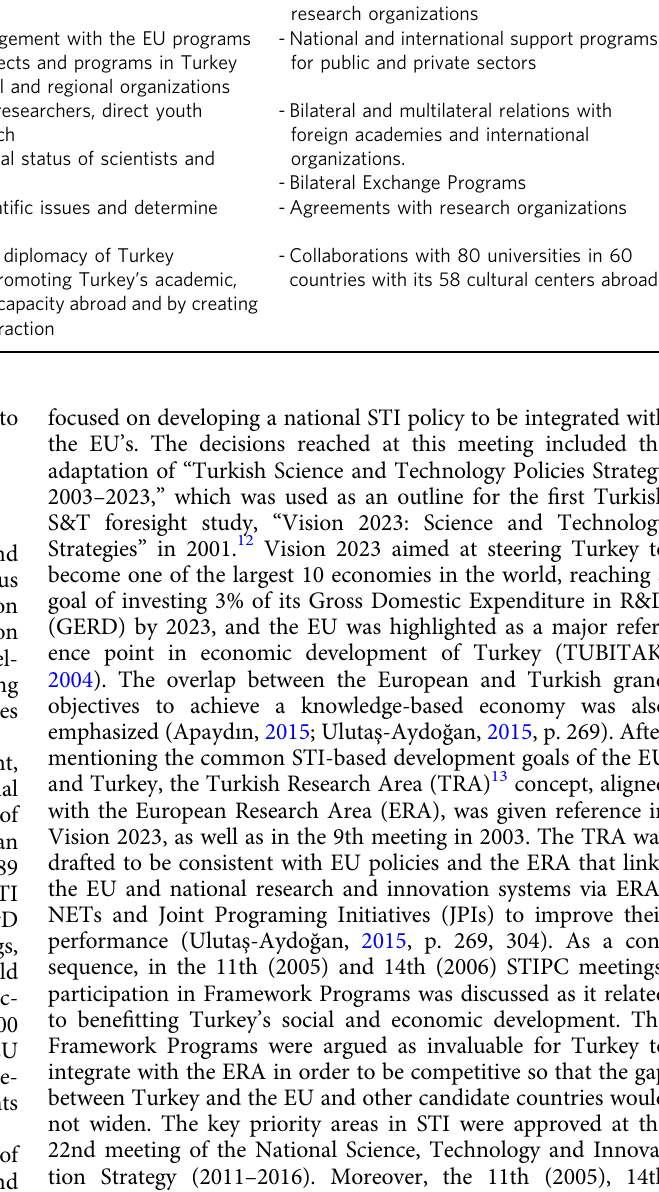
Table 1 summarizes institutions and organizations related to STI polices and SD in Turkey.